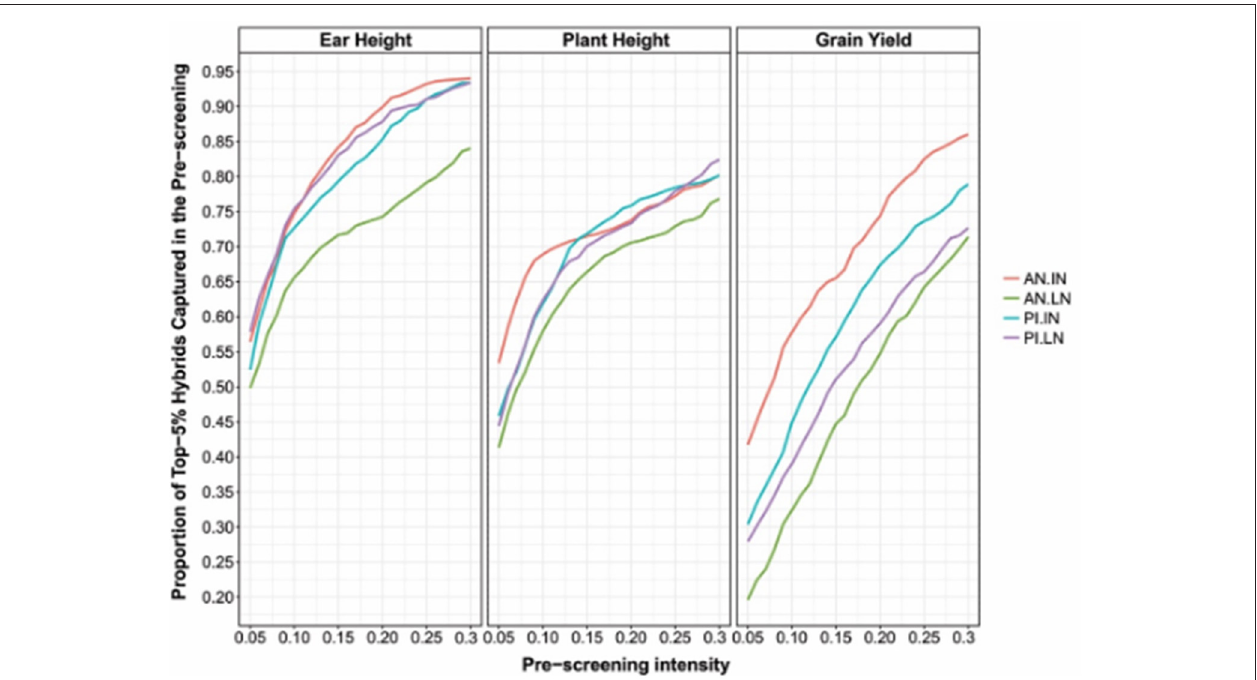
FIGURE 5 | According to phenotypic classification, the proportion of 5% higher hybrids was identified by pre-screening based on cross-validation via GP using the additive + dominance model at a certain selection intensity (x-axis). Each panel corresponds to one evaluated character. The lines within a graph represent different environments (AN: Anhembi; PI: Piracicaba; LN: Low nitrogen; IN: Ideal